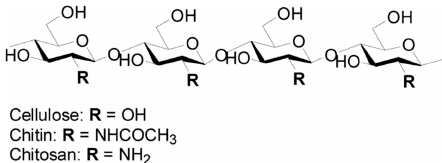
Figure 1. Chitosan, chitin and cellulose molecular structures (Modified from [2]).